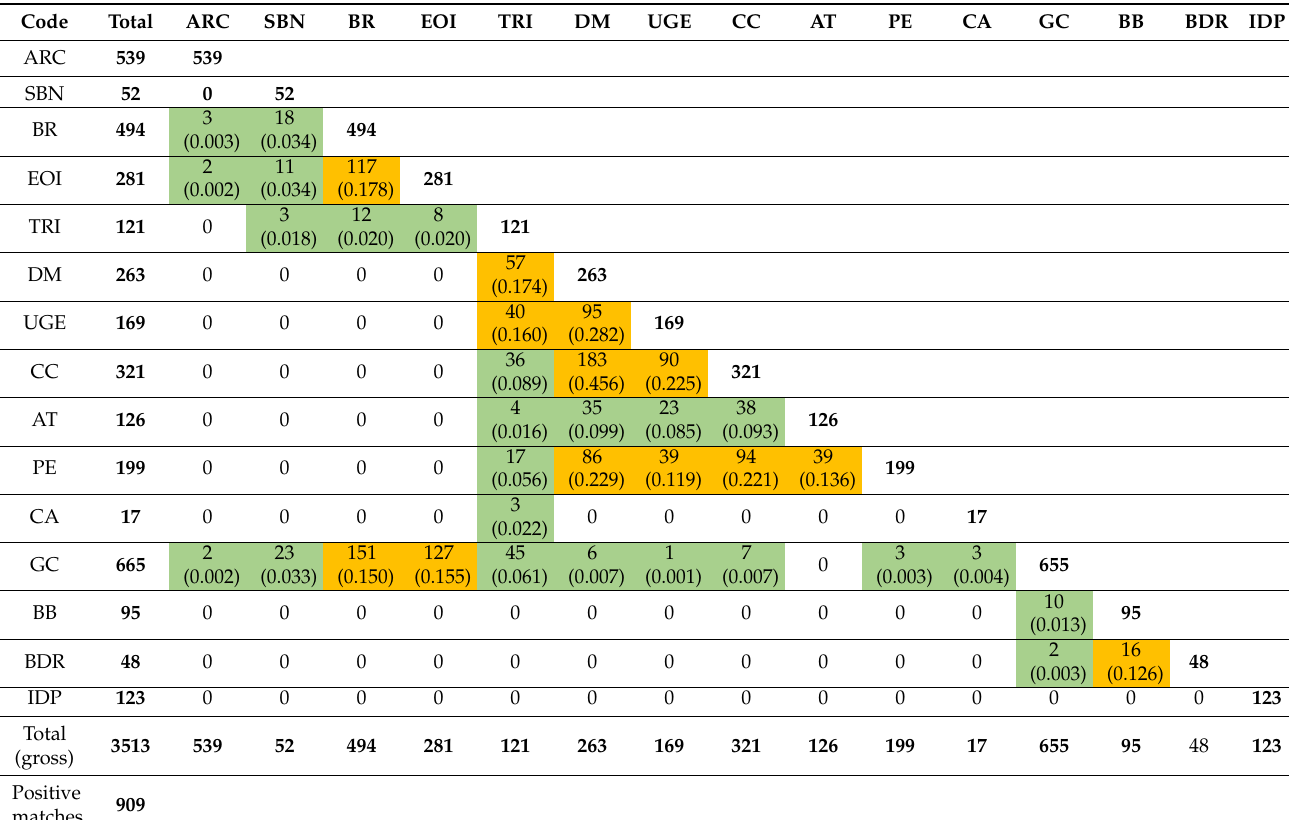
Table 3. The result of the matching between photo-ID catalogues (the number of individuals shared across the different catalogues) and relative SRI between catalogues (in parentheses). The SRI can vary from 0 (no individuals shared between catalogues) to 1 (all the individuals in the first catalogue are present in the second one and vice versa). In green the cells with SRI > 0, in orange the cells with SRI > 0.1.